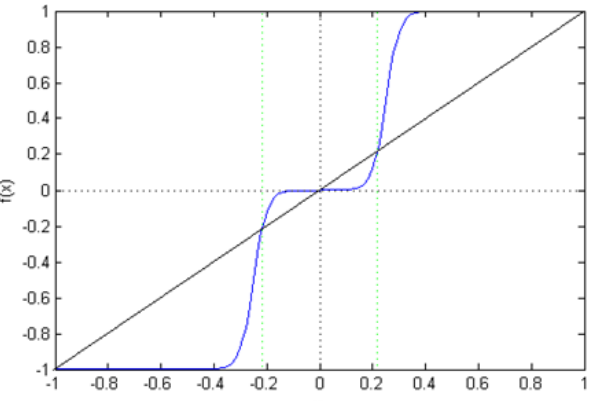
From Eq. (3), the mRTV value will be very small in the smooth region of the image and also very sensitive to noise.